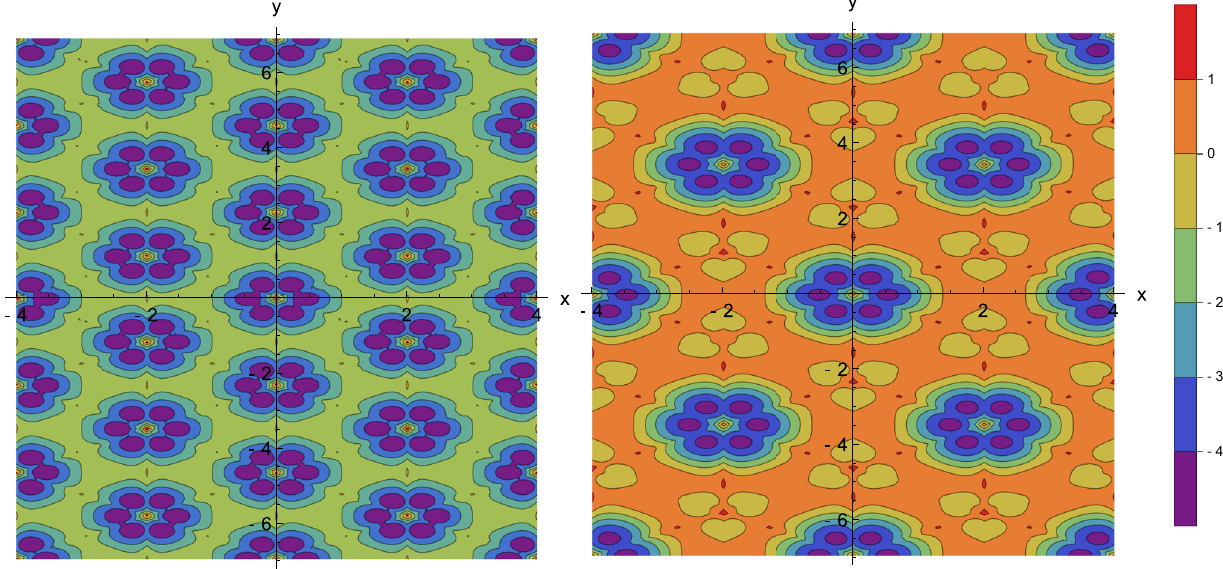
Fig. 2 Contour plot of the effective potential (14) for ξ = − 1, g = 4 and N f = 0 (left panel), N f = 3 (right panel). The replications